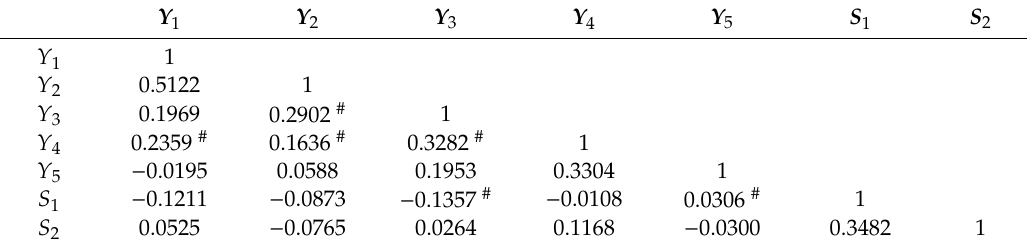
Table 14. Spearman’s Rank correlation matrix of the perturbed data using the CGADP